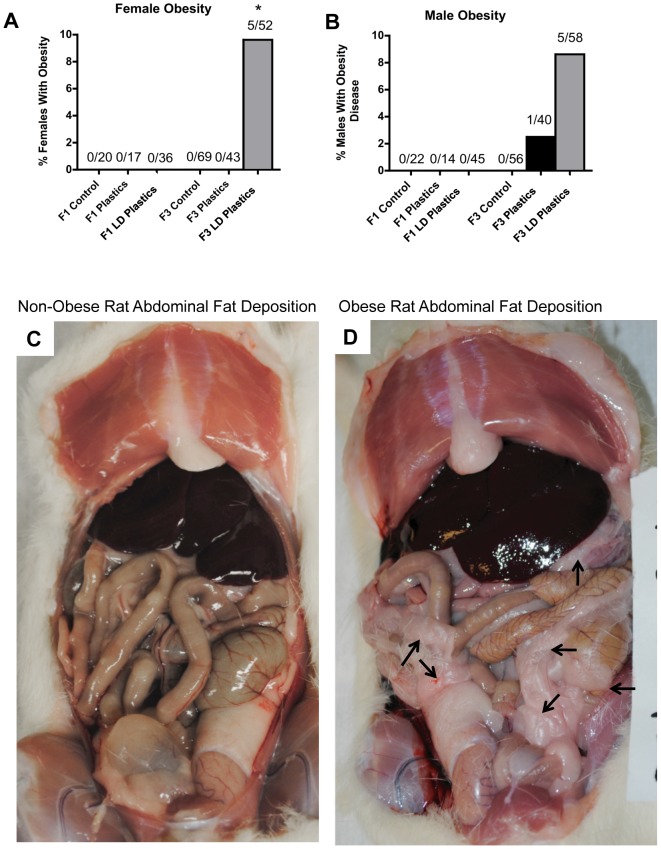
Obesity developed in control, plastics, or lower dose(LD) plastics (BPA, DEHP and DBP) lineages. Percentages of females (panel A) and males (panel B) with obesity in F1 and F3 generations are presented. The actual number of diseased rats/total number of rats in each group are shown above the respective bar graphs (* P<0.05). Abdominal fat deposition in F3 generation 1yr old rats from non-obese (C) and obese (D) animals. Pink colored fat deposition over most organs noted in panel B (arrows).